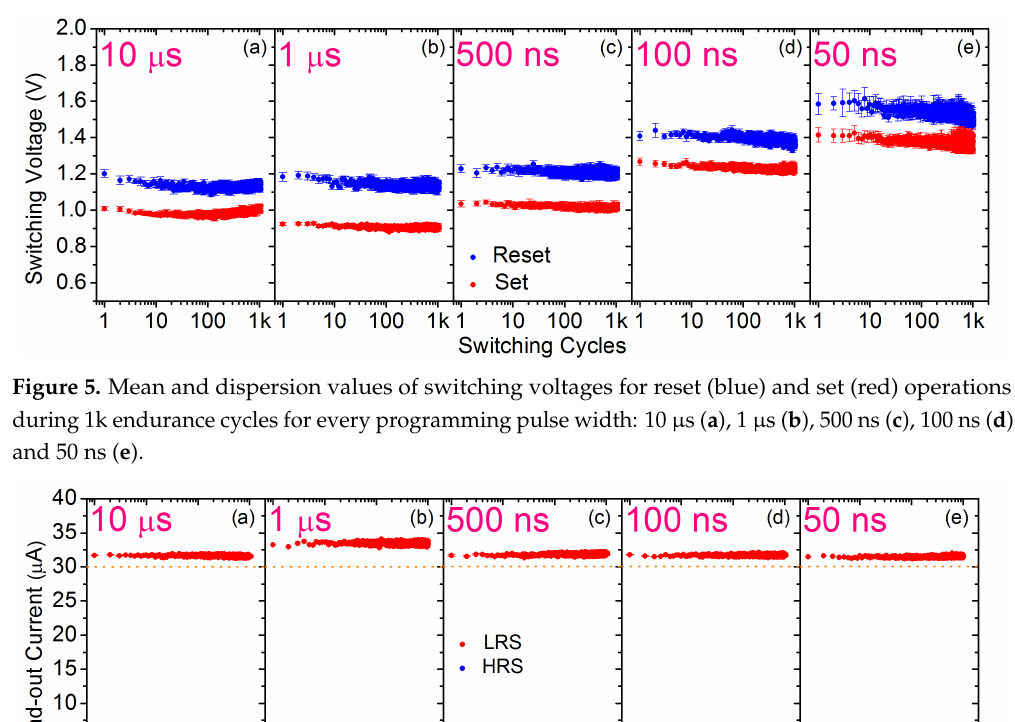
Figure 4. Average energy required to perform reset (blue dots) and set (red dots) operations on a single 1T1R resistive random access memory (RRAM) cell. The total value is split between the energy associated to programming (solid dots) and read-out (empty dots) pulses.